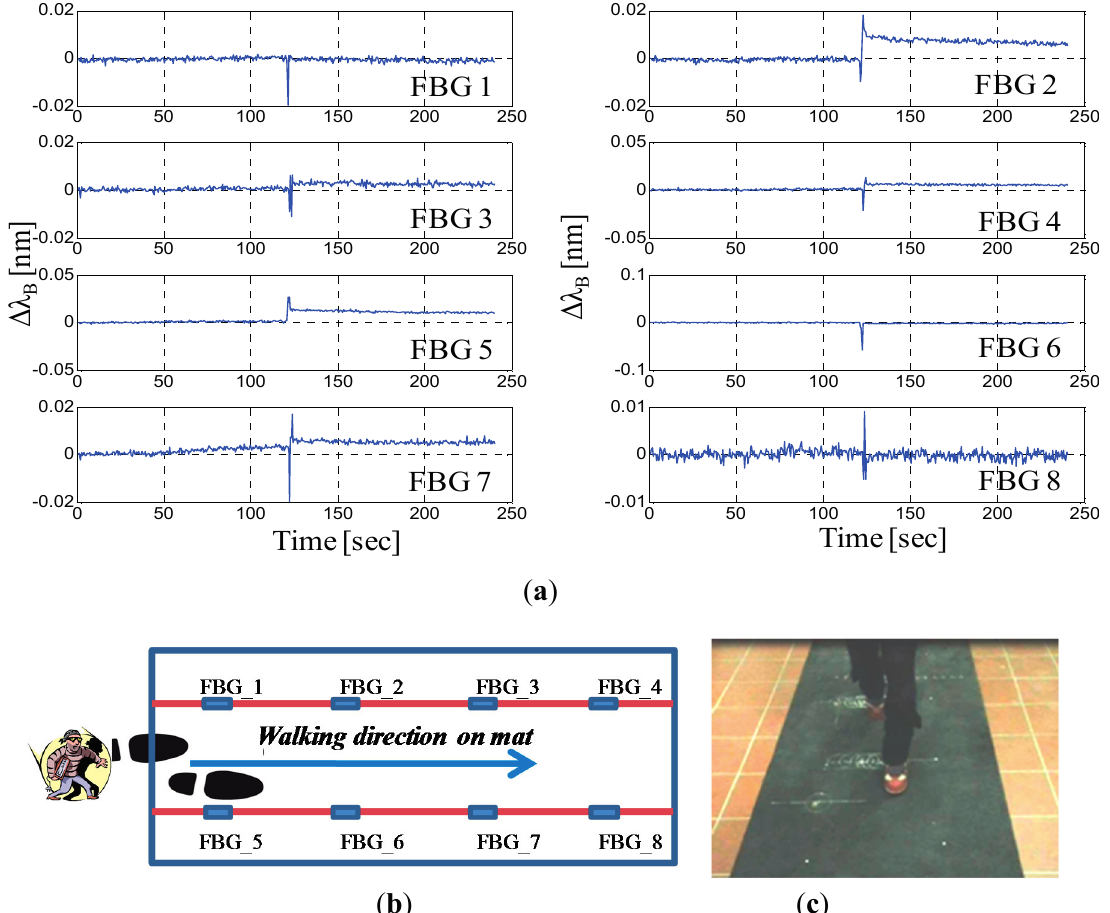
Figure 7. ( a ) Bragg wavelength shift versus time; ( b ) Schematic of the intruder’s crossing pattern; ( c ) Photo of the walking test on the